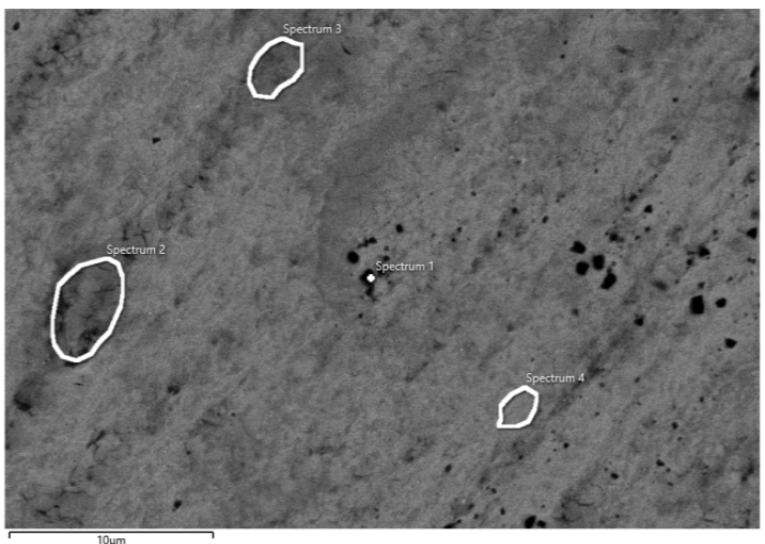
Figure 9. SEM image of CP Ti after impedance measurements in PBS solution with marked spots of EDS analysis. Table 6. Elemental composition on different spots (position 1-4) on surface CP Ti after impedance measurements in PBS solution .